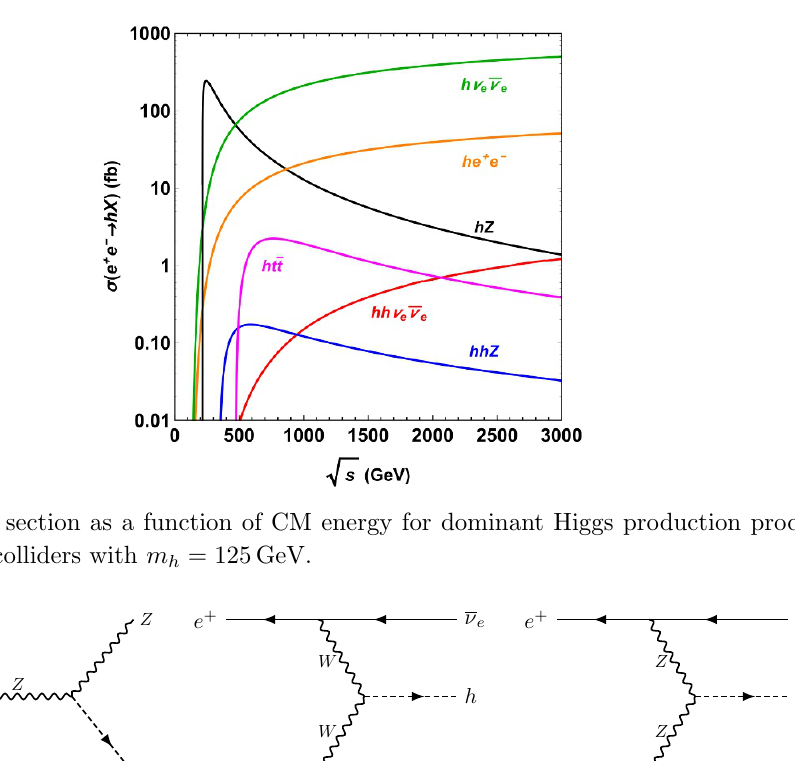
(cid:0) colliders.